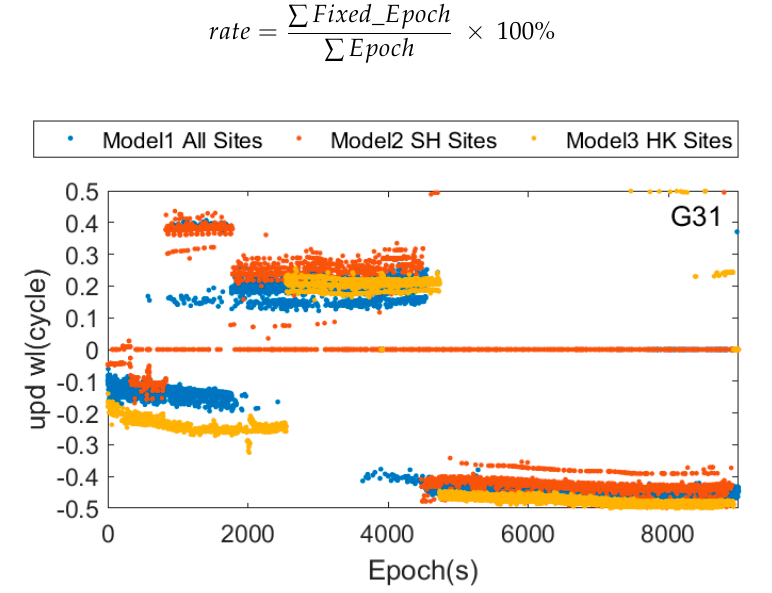
Figure 7. Wide-lane uncorrected phase delay of G31 in three UPD models.